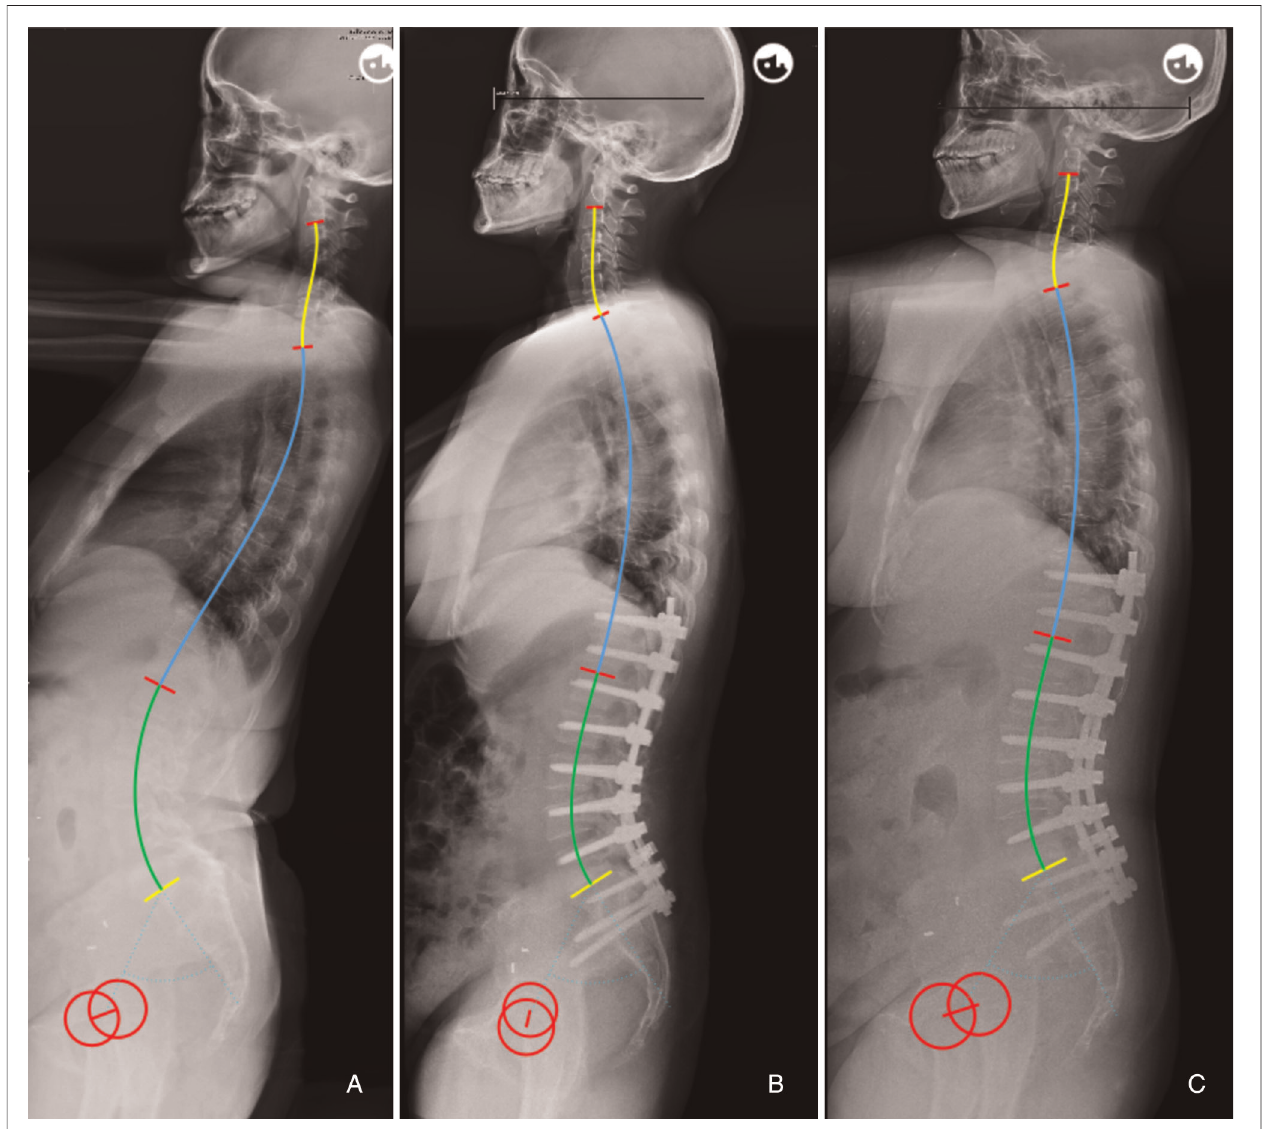
FIGURE 4 | 60-year-old female ( A ) preoperative sagittal standing full spine X-rays, pelvic incidence (PI)=58.5°, thoracic kyphosis (TK)=8.4°, lumbar lordosis (LL)= − 60.5°. ( B ) immediate postoperative X-rays, PI=57.8°, TK=24.7°, LL= − 48.3°; ideal LL=0.7*57.8+0.4*24.7+1= − 51.3°, Δ LL=48.3 – 51.3=3.0°. ( C ) no mechanical complications at 2-year